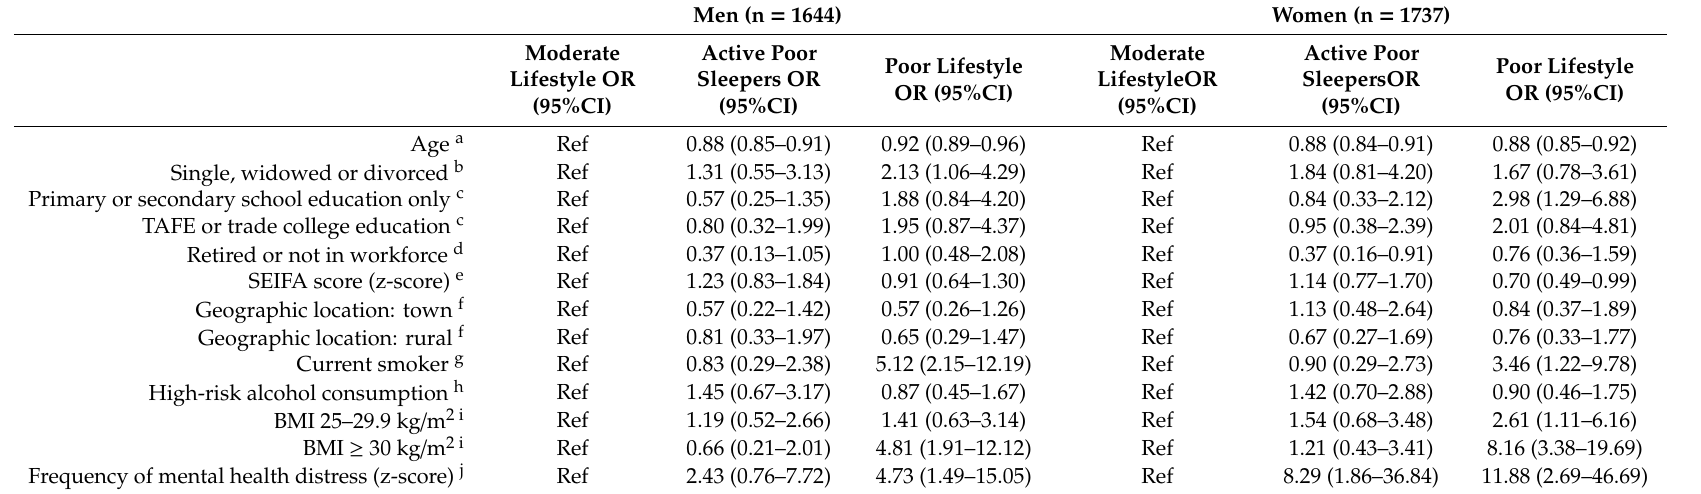
Table 3. Odds of class membership by sociodemographic and health-risk characteristics (n = 3374). Men (n = 1644) Women (n =